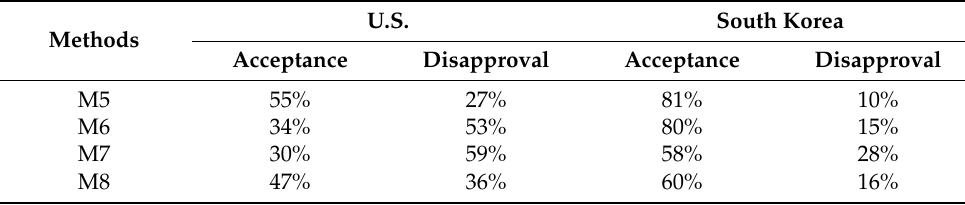
Table 8. Acceptance and disapproval rates for the four self-quarantine monitoring methods.